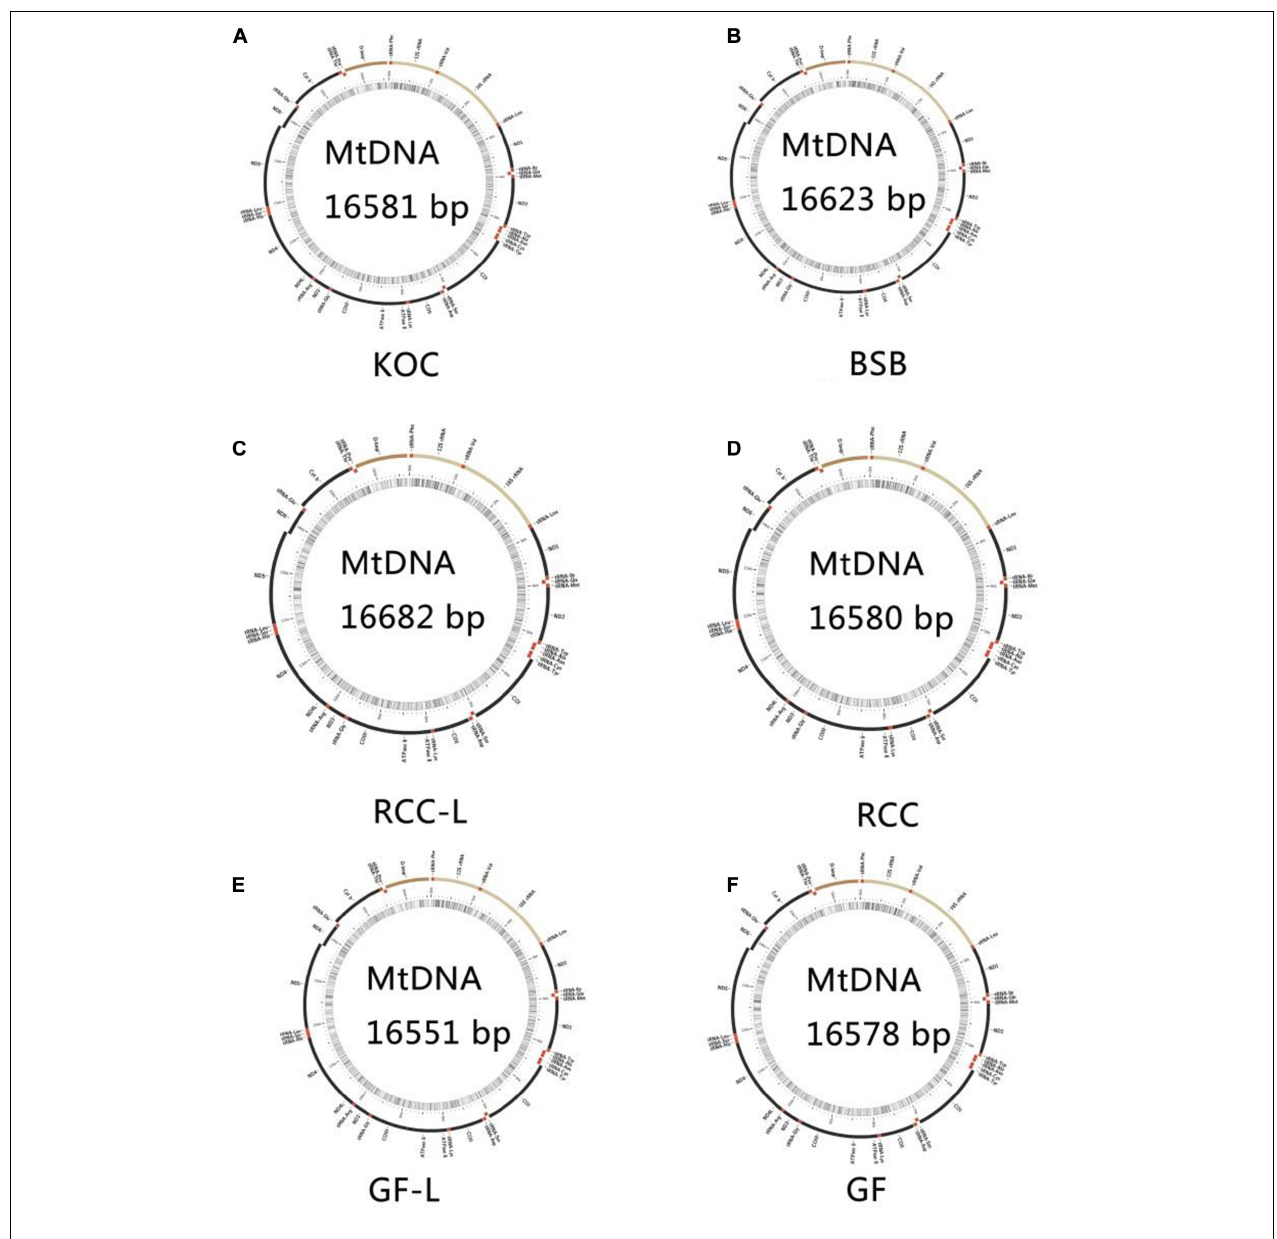
FIGURE 2 | The structure of the mtDNA of (A) KOC, (B) BSB, (C) RCC-L, (D) RCC, (E) GF-L, and (F) GF.